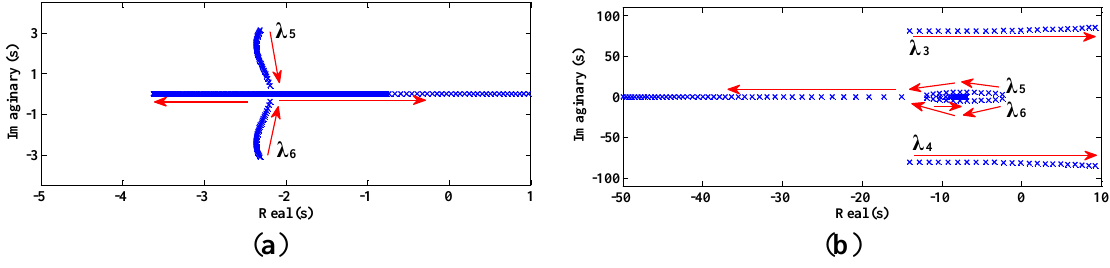
Figure 6. Eigenvalue analysis. ( a ) Trace of the dominant poles when K p2 increases; ( b ) Trace of the dominant poles when K i2 increases.